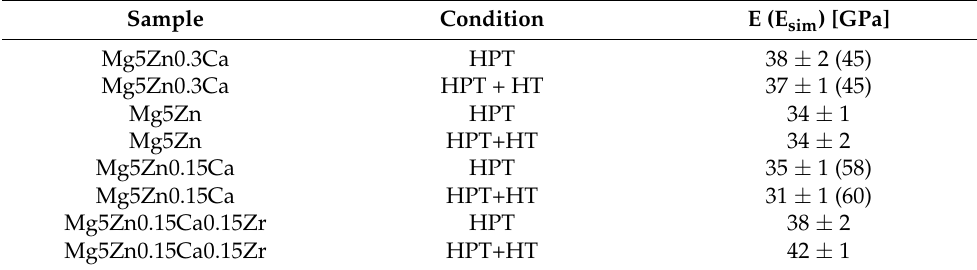
Table 4. Young’s modulus E measured by indentation microhardness of the alloys after HPT- processing by 10 rotations at 285 ◦ C, and after additional heat treatment at 100 ◦ C for 24 h. Simulated values E sim are given in